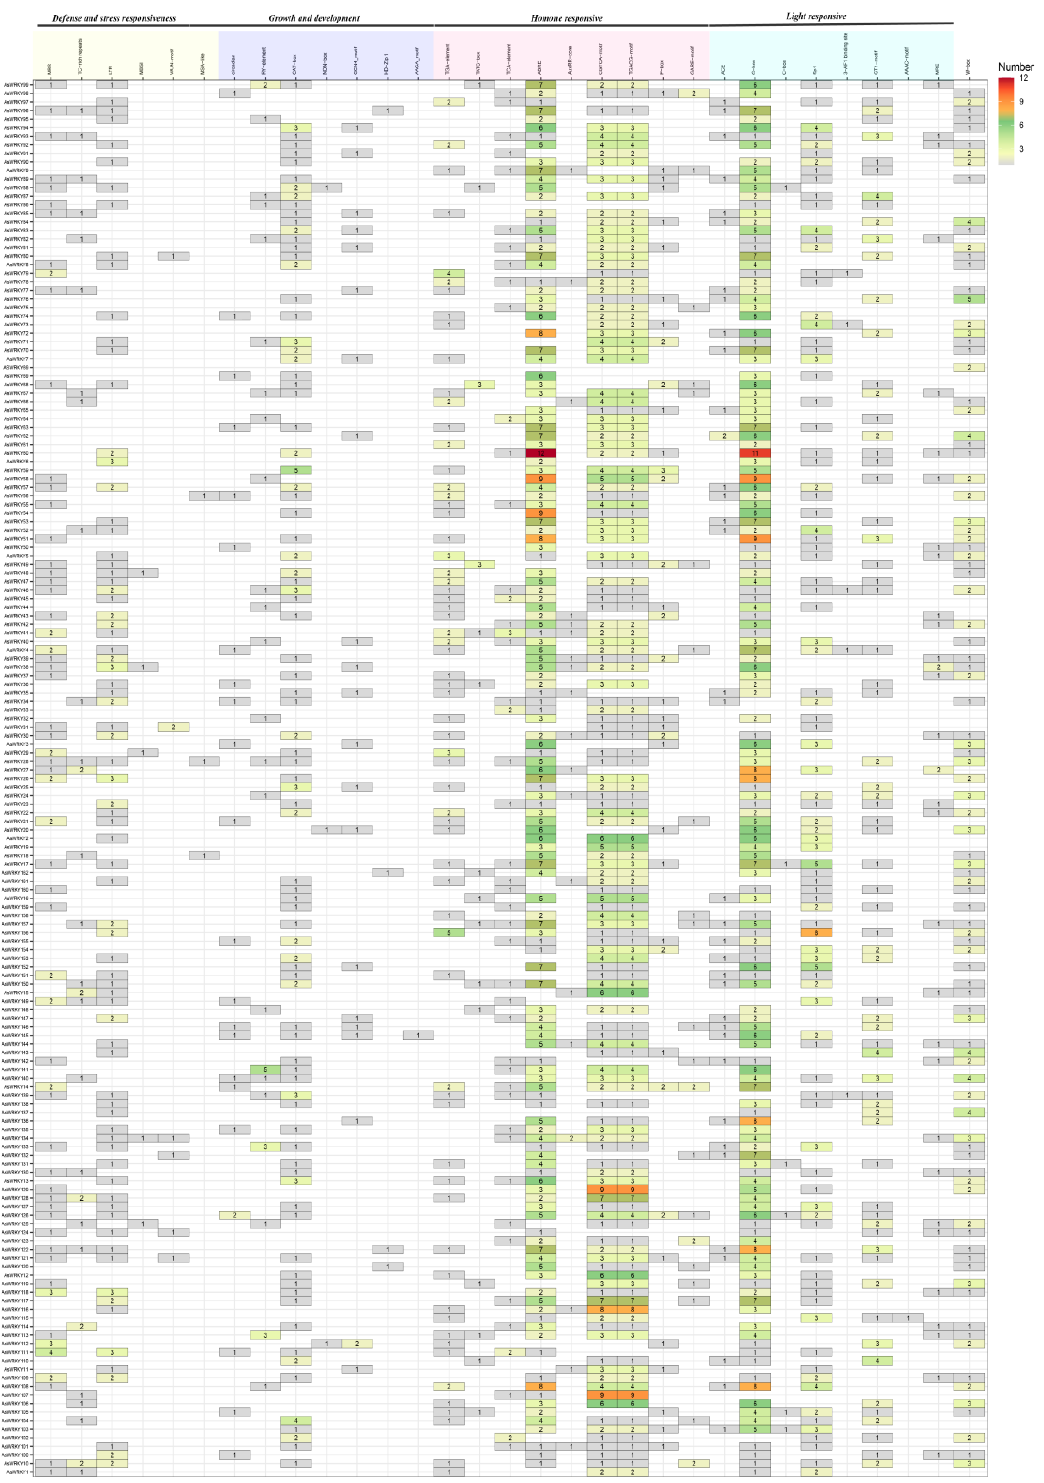
Figure 7. The cis -element in the promoter of AsWRKY genes. 3-AF1 binding site, light responsive element; AAAC-motif, light responsive element; AACA-motif, involved in endosperm-specific negative expression; ABRE, cis-acting element involved in the abscisic acid responsiveness; ACE, cis-acting element involved in light responsiveness; AuxRR-core, cis-acting regulatory element involved in auxin responsiveness; CAT-box, cis-acting regulatory element related to meristem